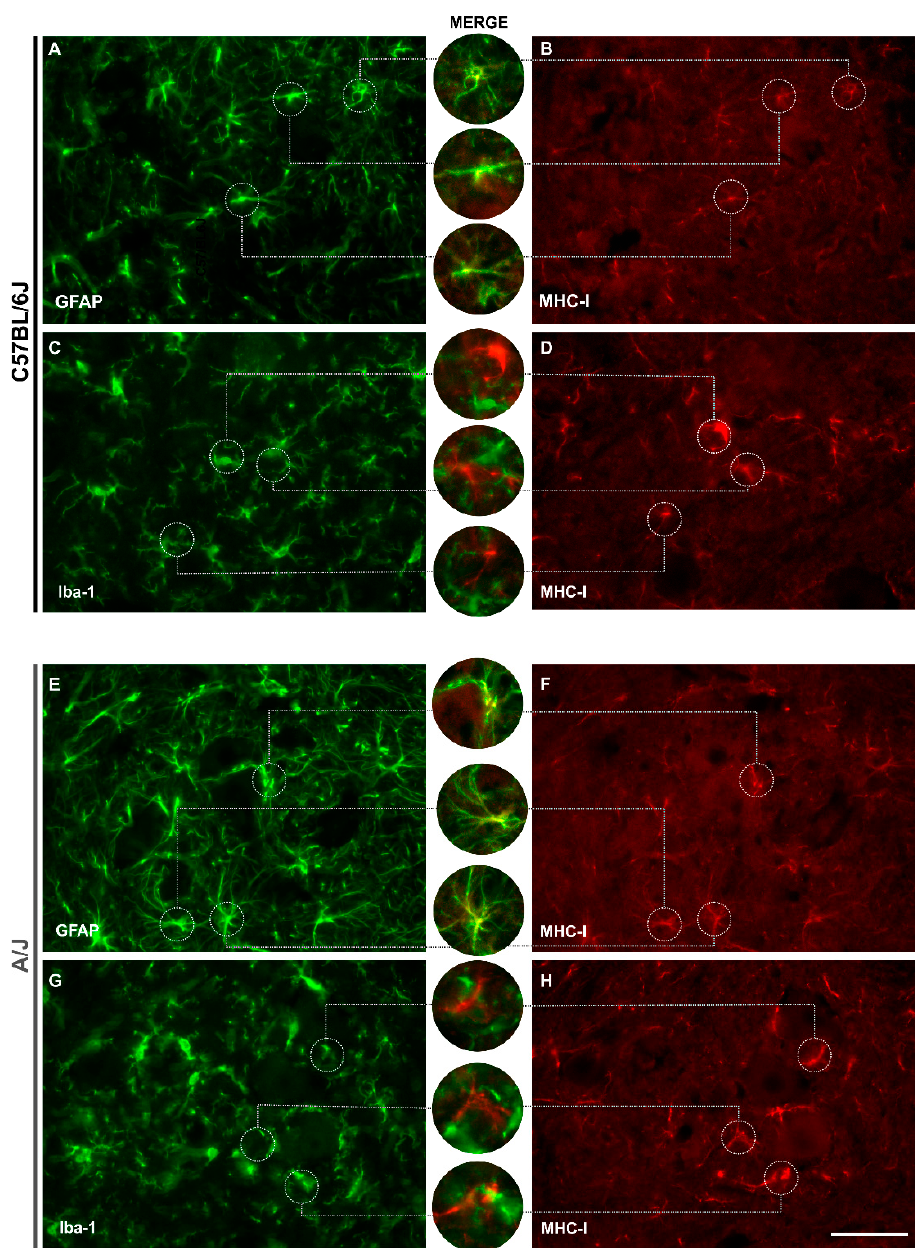
Figure 7. Double labeling for major histocompatibility complex class I (MHC-I) and astrocytic (GFAP) or microglial (Iba-I) cells in C57BL/6J and A/J strains 7 days after injury (7 dal). In the C57BL/6J mice, colocalization is observed between the anti-GFAP and MHC-I antibodies ( A , B ), which does not occur in the anti-MHC-I and anti-Iba-I double staining analysis. ( C , D ). The same pattern was observed in the A/J mice, both for astrocytes ( E , F ) and for microglia ( G , H ). Scale bar: 50 µm.